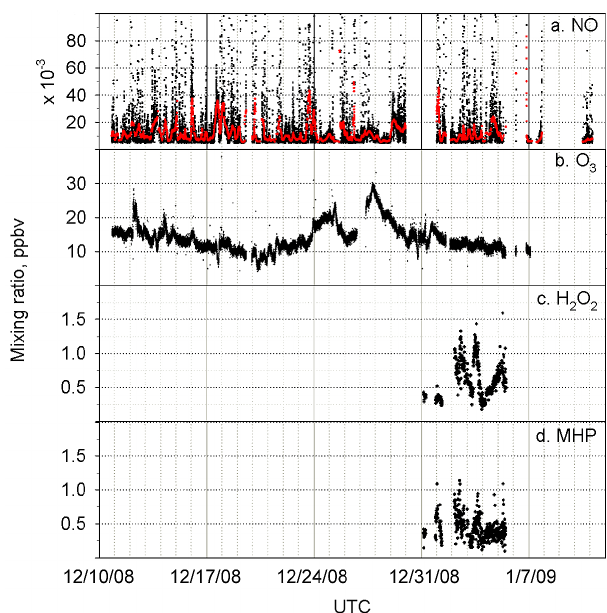
Fig. 1. Atmospheric mixing ratios of NO after filtering and O 3 (1min averages), and of H 2 O 2 and MHP (10-minute averages) dur- ing austral summer 2008–2009 at WAIS Divide. The 4h running median of NO is also shown (red symbols).